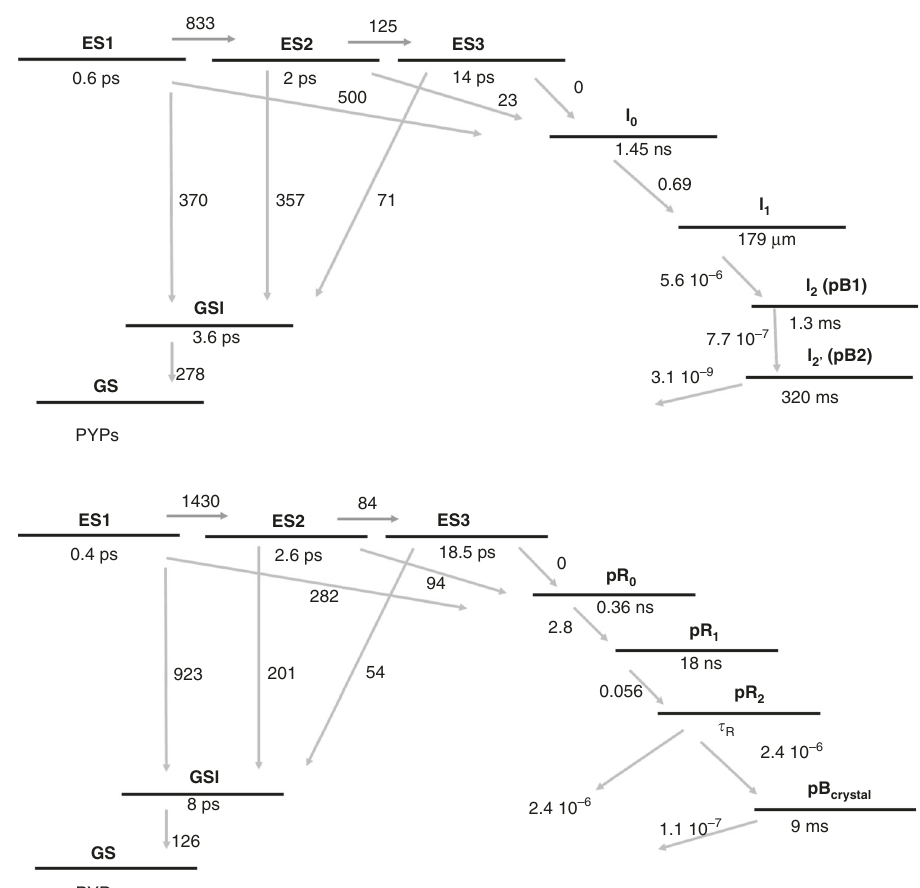
Fig. 4 Kinetic schemes of the photocycle of PYP in solution and in crystalline form. Top panel: PYP in solution, bottom panel: PYP in crystalline form. Upon absorption of light by pCa in the ground state (GS), the excited state is formed from which the system transitions through the reaction. The relevant states are indicated by the following abbreviations: ES 1-3 : excited states sharing the same spectrum, evolving sequentially from 1 → 2 → 3; GSI: ground state intermediate; I 0 , I 1 , I 2 (pB1), I 2 ’ (pB2), pR 0 , pR 1 , pR 2, pB crystal : photocycle intermediates. Note that we use the symbol “ I X ” for notation of PYP S intermediate states, and “ pC ” (with C for color, i.e., red or blue) for those in PYP C , except for the fi nal pB states. The transition rates indicated near the arrows are in ns − 1 , the lifetime of each state is indicated in italic. The rate constants involving the ES and GSI for PYP S have been fi xed from ref. 24 , all other parameters have been estimated. Note that in the crystal as evidenced from the UV – Vis data 19 half of the pR 2 states is converted to pB, whereas the other half branches directly to the ground state, with a rate of k R,VIS 2.4× 10 − 6 . Note that the longer time scales (after 100 ms) are based solely on the the UV – Vis data of ref. 19 . Concentration pro fi les computed with these kinetic schemes for the photocycle intermediates states are shown in Supplementary Fig. 7.